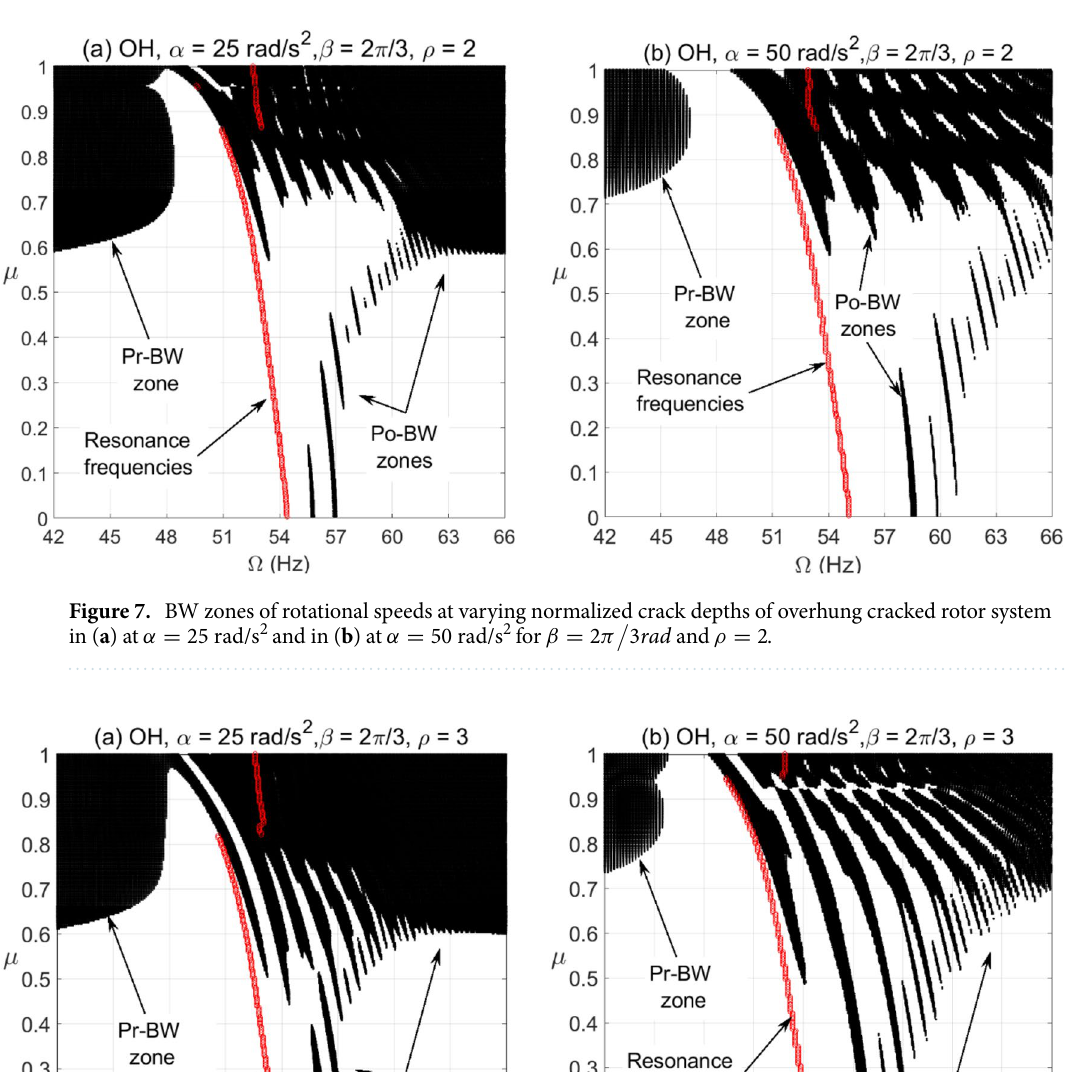
2 3 rad and ρ = 3 for β = 2 π (cid:31)